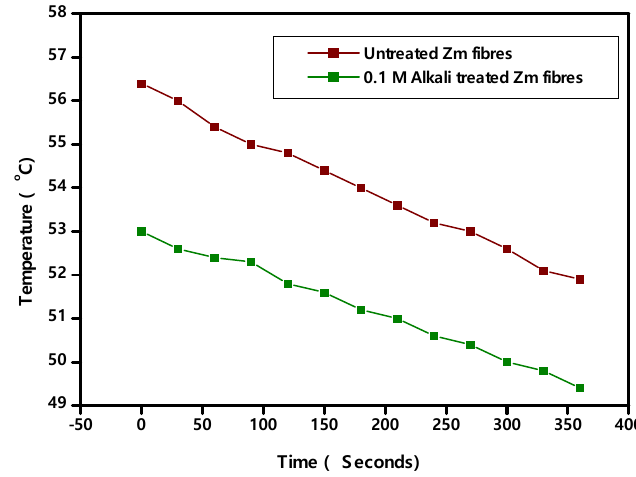
Figure 3. Thermal conductivity graph for Zea mays fibres.